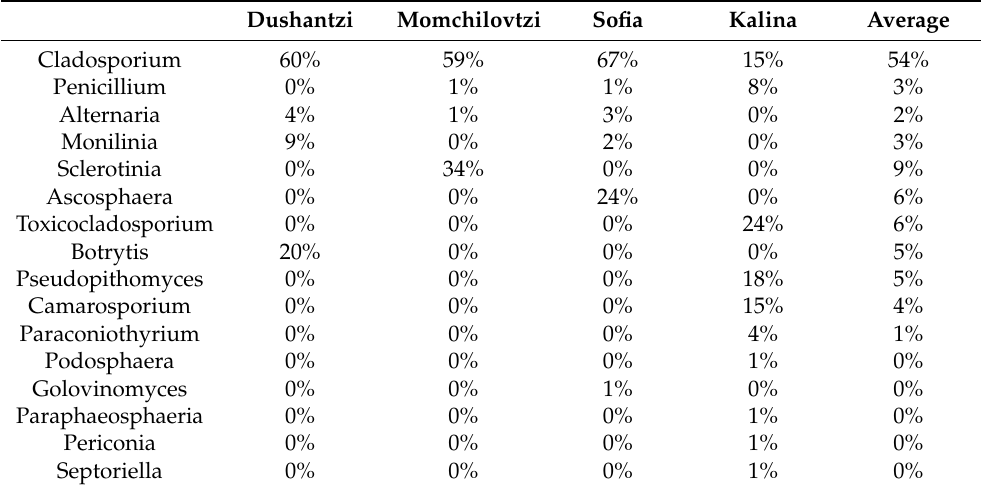
Figure 5 . Krona display of the fungal composition of the samples from Kalina. Figure 5. Krona display of the fungal composition of the samples from Kalina. Table 4. Relative abundance of the Ascomycota genera found in the four locations 1